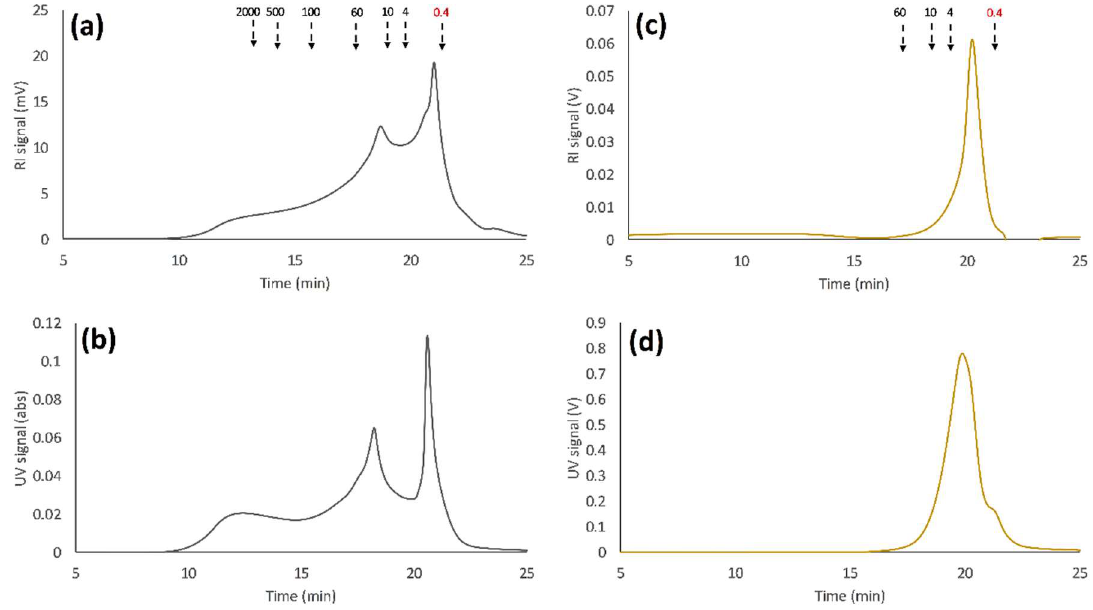
Figure 3. Size-exclusion chromatography (SEC) of the untreated spent-sulfite-liquor raw material; where ( a , b ) are the RI and UV detector response respectively using water as eluent. ( c , d ) are the RI and UV detector response respectively using 100 mM NaOH as eluent. Arrows point to the peak maximum of the various dextran standards, except for the lowest MW standard (0.4 kDa) which was PEG.